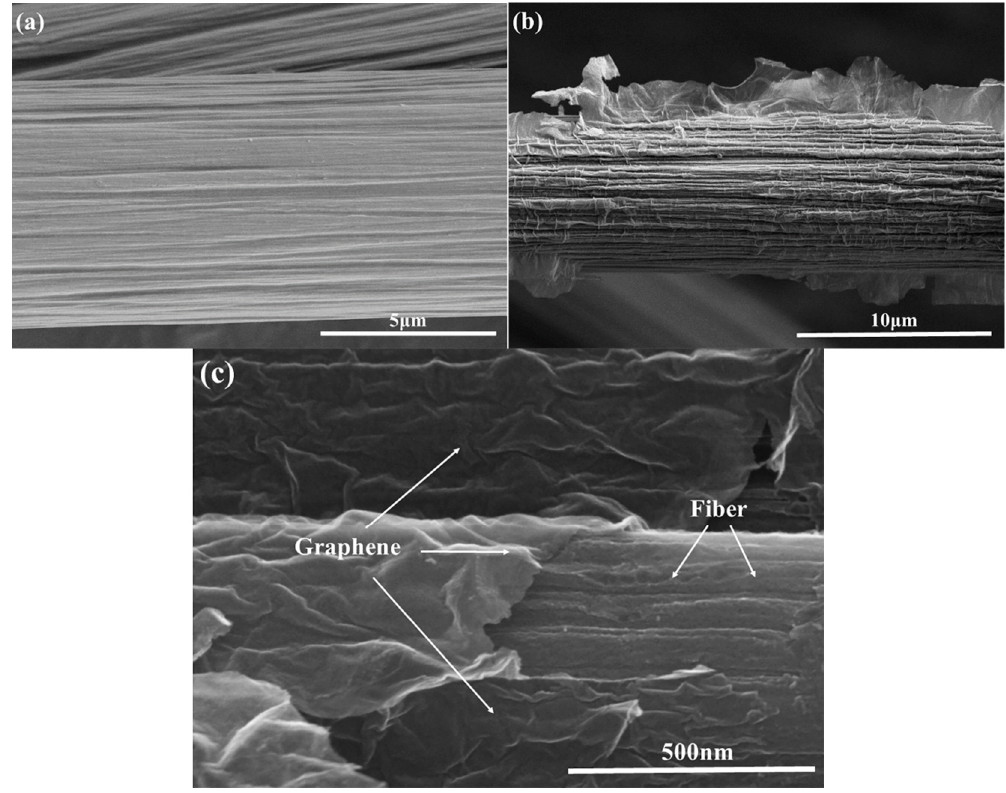
Figure 4. SEM images of: ( a ) untreated carbon fibers; ( b ) graphene-modified carbon fibers and ( c ) high-magnification for graphene on the fiber.